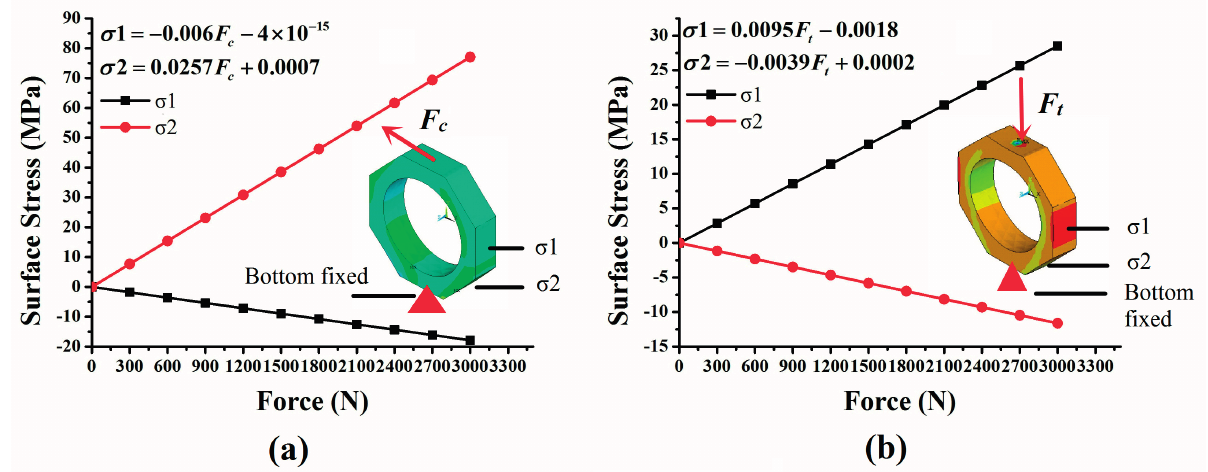
Figure 3. ( a ) FEM result for octagonal ring under the effect of F c ; ( b ) FEM result for octagonal ring under the effect of F p